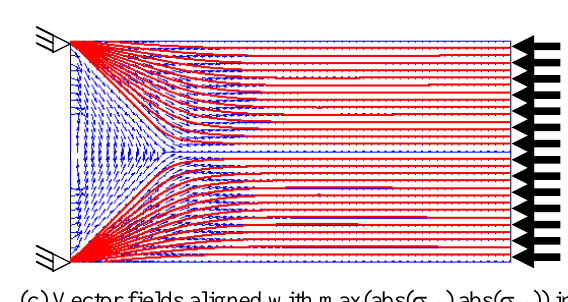
Fig. 16. Load paths based on U * for rectangular de fully constrastructure with its left si ined. Blue indicates